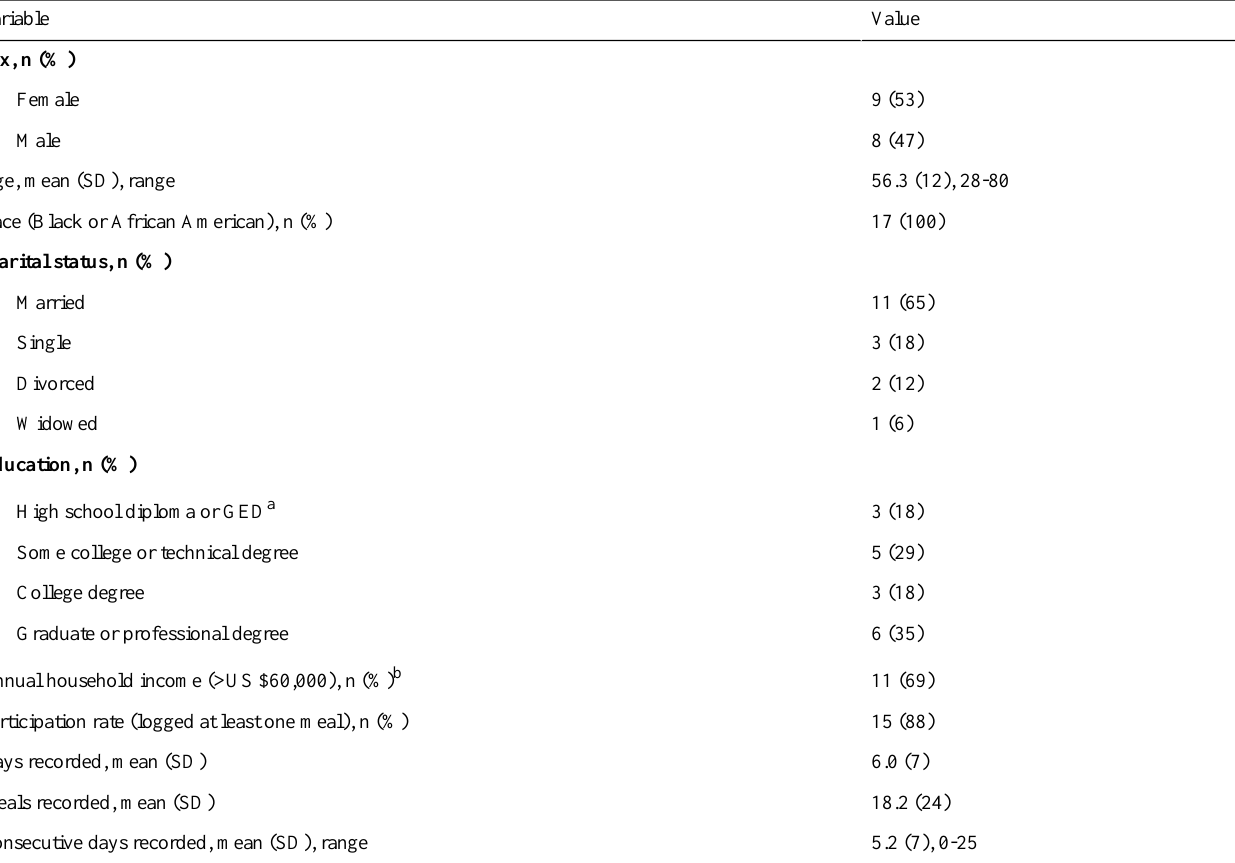
Table 1. Participants’characteristics (n=17); CV Health and Needs Assessment Qualitative Study.